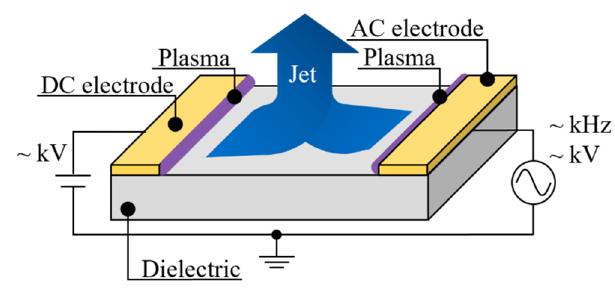
Figure 3. Schematic of a corona discharge plasma actuator.